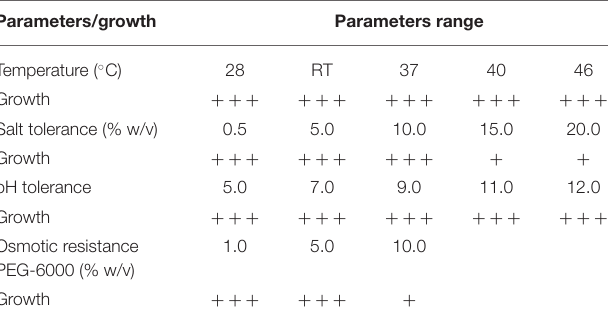
TABLE 4 | Abiotic stress response of Bacillus sp.